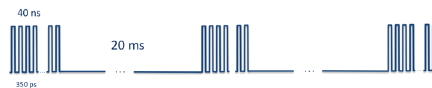
Figure 2. Time structure of the BTF extracted beam.